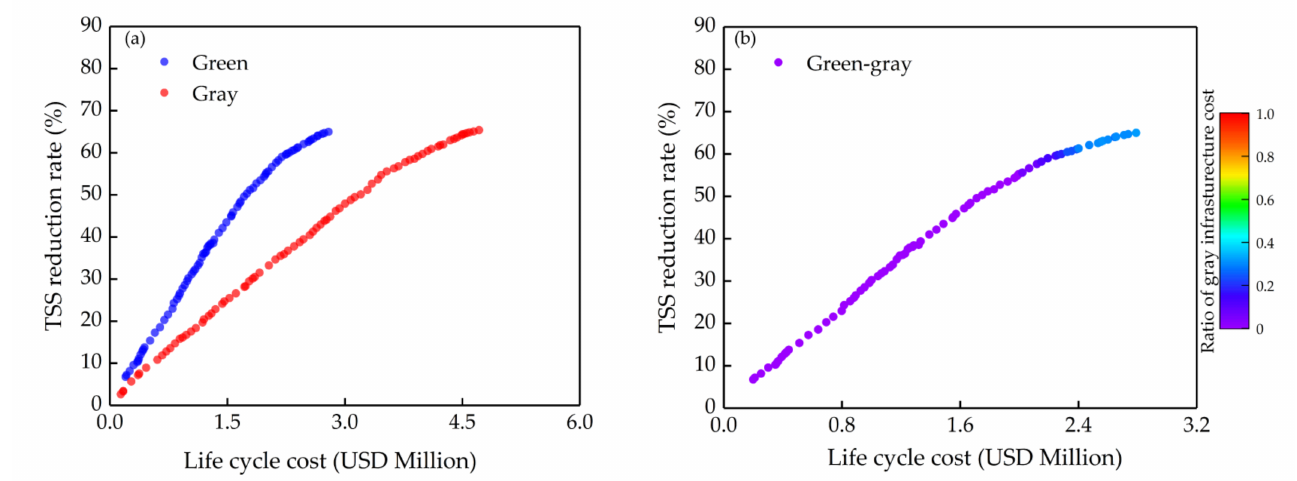
Figure 8. Pareto solution set curves when the α coefficient is 5: ( a ) Separate optimizing (green infrastructure only and gray infrastructure only); ( b ) Synchronous optimizing (green-gray infrastructure).